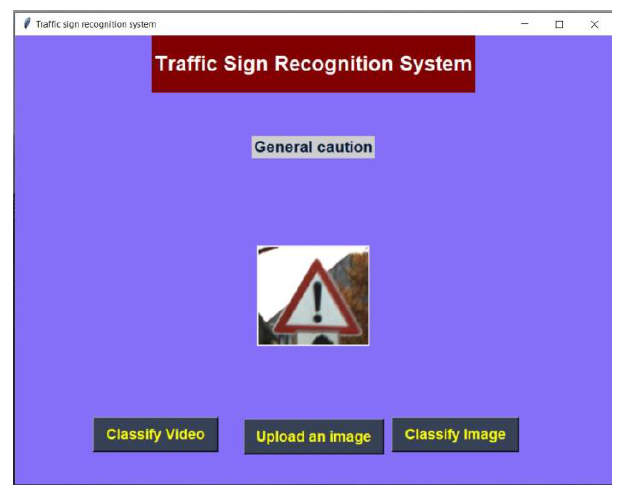
Fig. 15.4 Classification Result of Static Image Fig 15.4 shows result of static image recognition. The chosen traffic sign is displayed on the screen along with the class it belongs to.